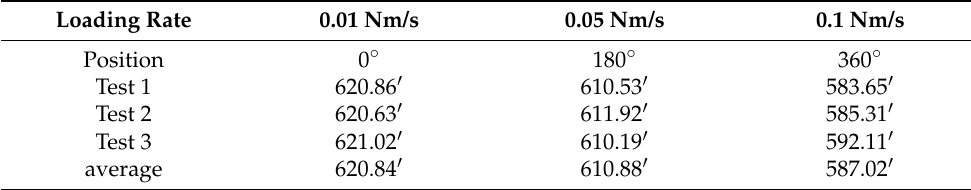
Table 10. Experiment results of δ